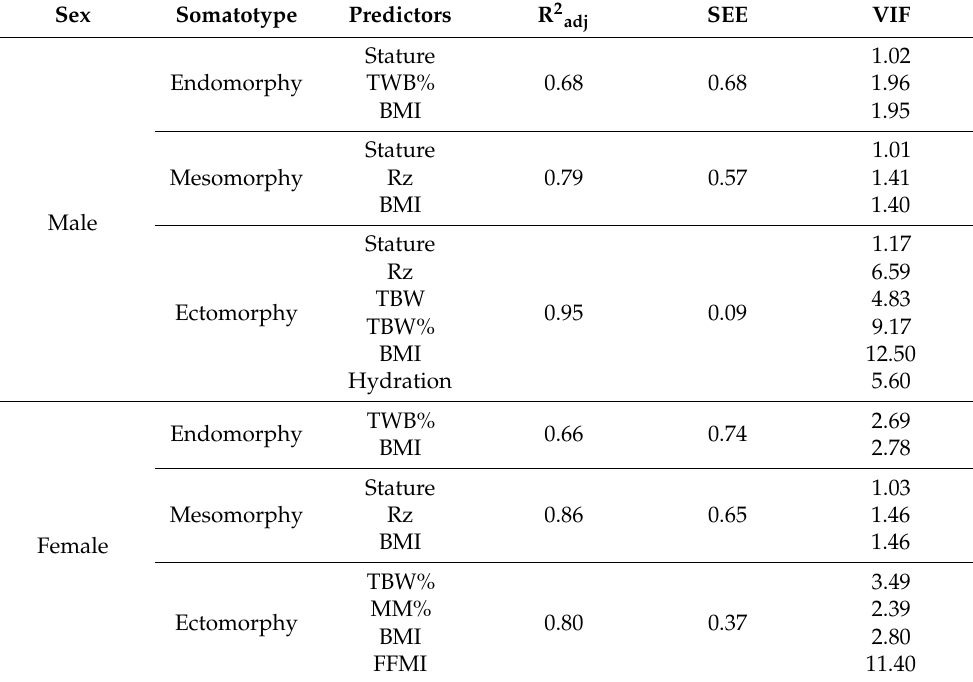
Table 2. Prediction models for endomorph, mesomorph and ectomorph somatotype